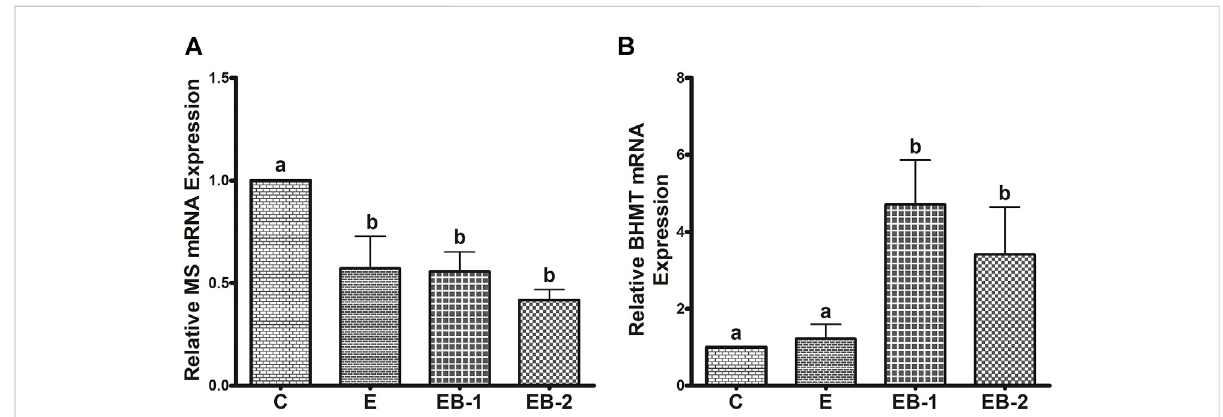
FIGURE 5 (A) MS and (B) BHMT mRNA quanti fi cation by qPCR. Levels of MS and BHMT mRNA in mice treated with saline [C], ethanol [E], or given betaine 2 h before [EB-1] or simultaneously with the ethanol binges [EB-2]. Data are presented as mean values ± SEM ( n = 5); values not sharing a common letter signi fi cantly differ from each other at p ≤